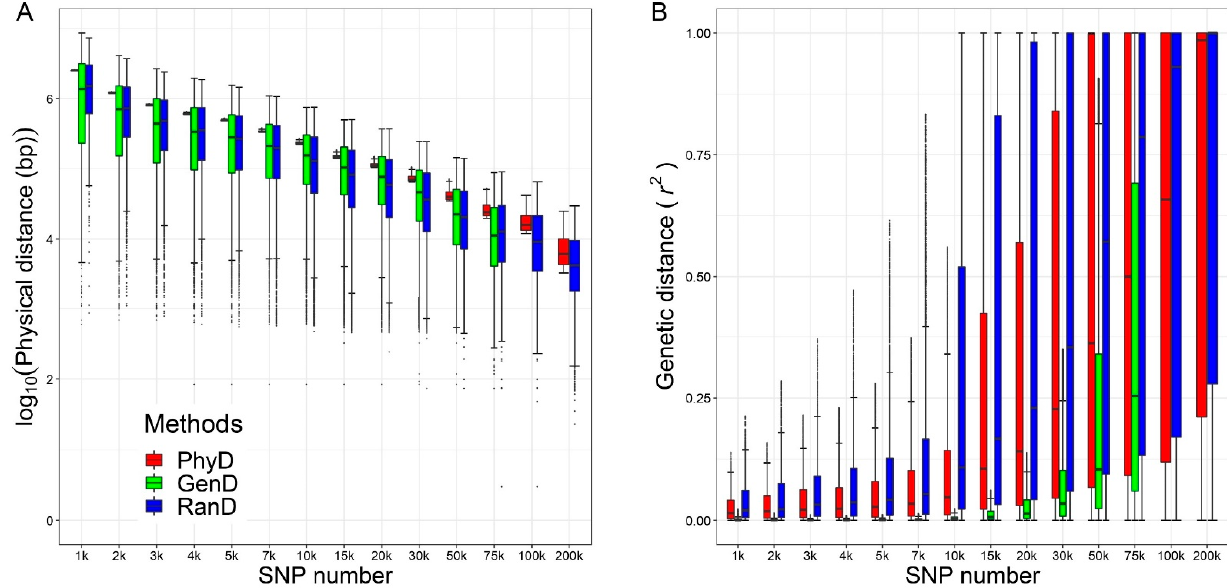
Figure 2. The measurements of ‘marker density’ for panels constructed in this study. The box and whiskers plot of the physical distance between adjacent SNPs ( A ) and the box and whiskers plot of genetic distance between adjacent SNPs ( B ) for panels in different SNP number levels generated by physical distance (PhyD), genetic distance (GenD) and random distance (RanD). Animals 2021 , 11 , 1992